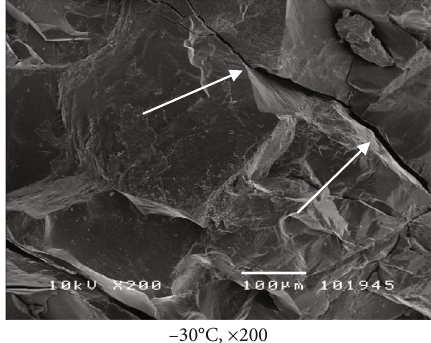
Figure 15: Intergranular fracture.